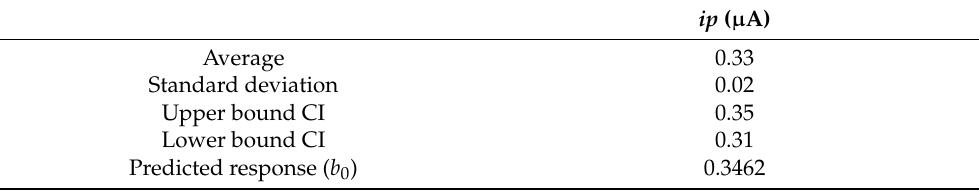
Table 4. Optimization of the prepolymeric mixture by a Full Factorial Design 2 3 : model validation by six replicates at the center point [0 0 0], i.e., 0.15 mmol MAA, 0.75 mmol EGDMA and 0.6 mL CH 3 OH. CI = confidence interval at 95% confidence level.